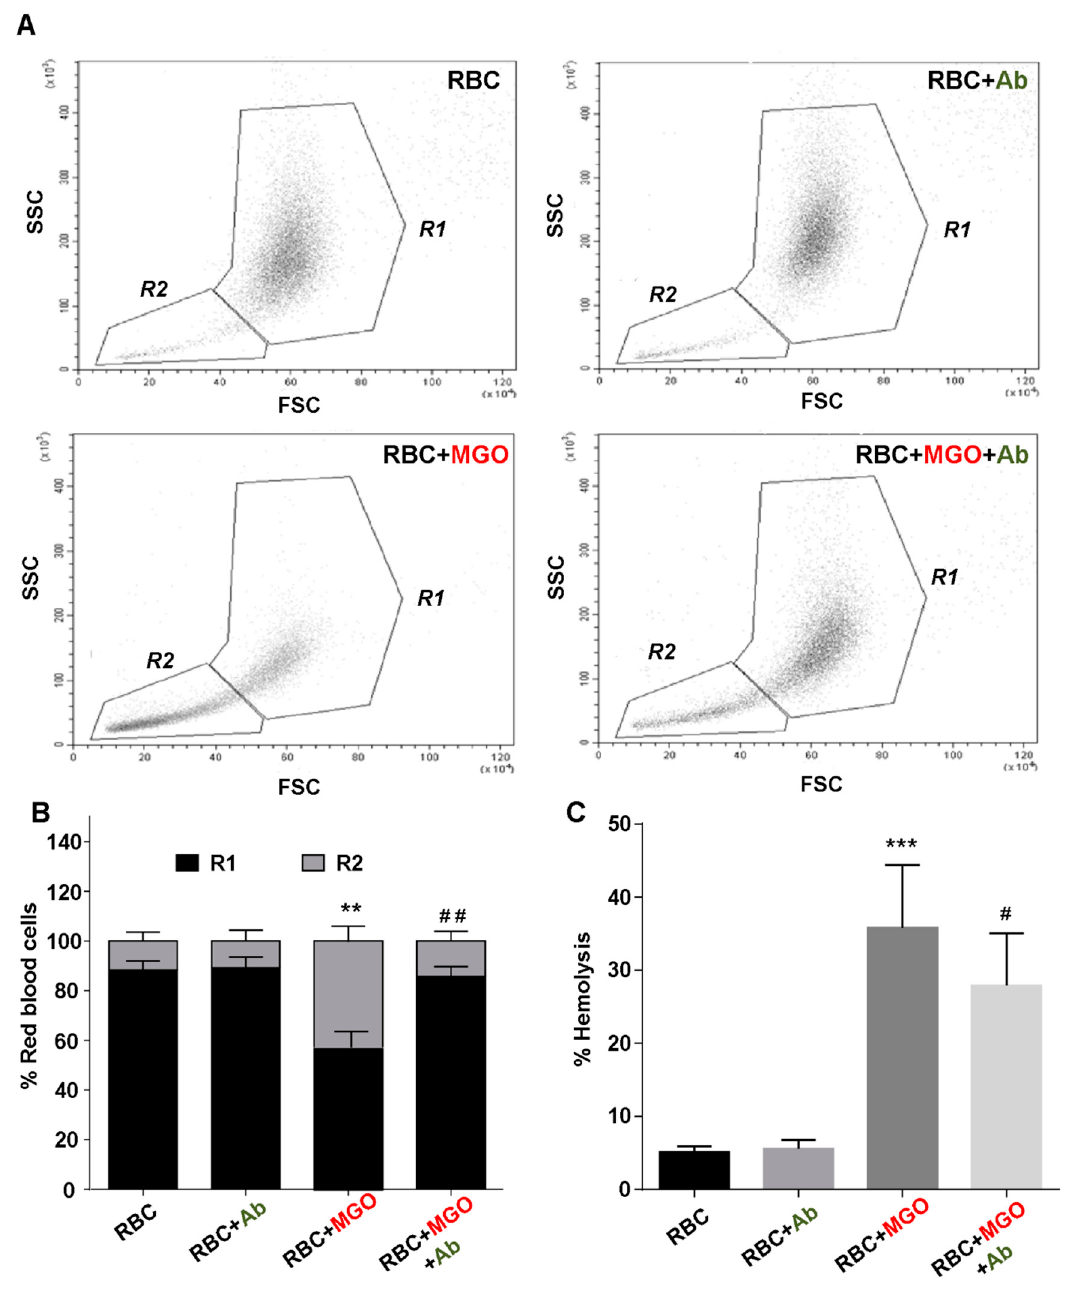
Figure 1. Protective e ff ect of Antirhea borbonica on erythrocytes morphology. Red blood cells morphology was investigated by flow cytometry. ( A ) Erythrocyte populations were gated according to cell location in a forward scatter (FSC) versus a side scatter (SSC) parameter. R1 and R2 gates represented respectively mature and senescent / aged erythrocytes for RBC (red blood cells); RBC + Ab (in green color); RBC + methylglyoxal (MGO, in red color) and RBC + MGO + Ab . ( B ) Average percentage of mature erythrocytes (R1) and altered erythrocytes (R2). ( C ) Average percentage of hemolysis induced by the change in solution tonicity (PBS → NaCl 0.9%). Data are mean ± SEM of five independent experiments. * E ff ect of MGO (vs. RBC), *** p < 0.001, ** p < 0.01. # E ff ect of Ab (vs. RBC + MGO), ## p < 0.01, # p < 0.05.